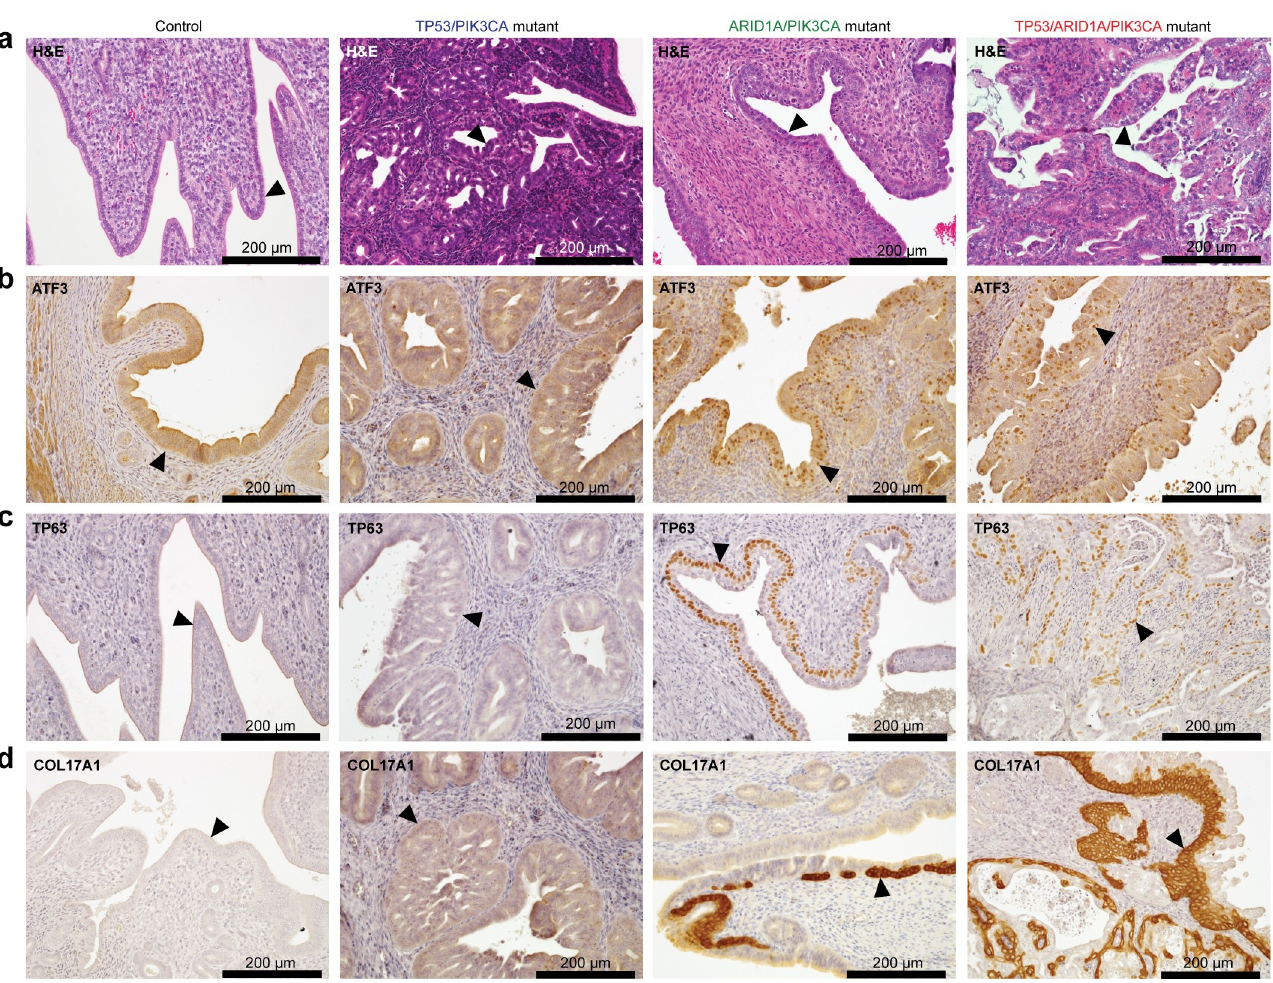
Fig 8. ARID1A loss relieves Atf3 repression associated with squamous differentiation. a , Representative H&E histology of (from left to right) control mice, TP53/PIK3CA mutants, ARID1A/PIK3CA mutants, and TP53/ARID1A/PIK3CA mutants. Arrowheads depict endometrial epithelia. b - d , Immunohistochemical staining of ATF3 ( b ), TP63 (GeneTex) ( c ), and COL17A1 ( d ) of mouse sections as in a